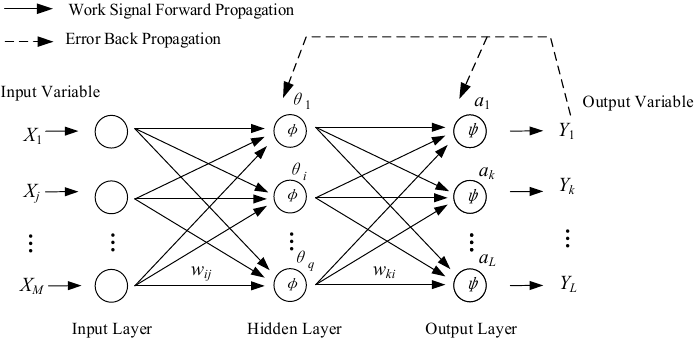
Figure 1. Back propagation neural network (BPNN) structure.